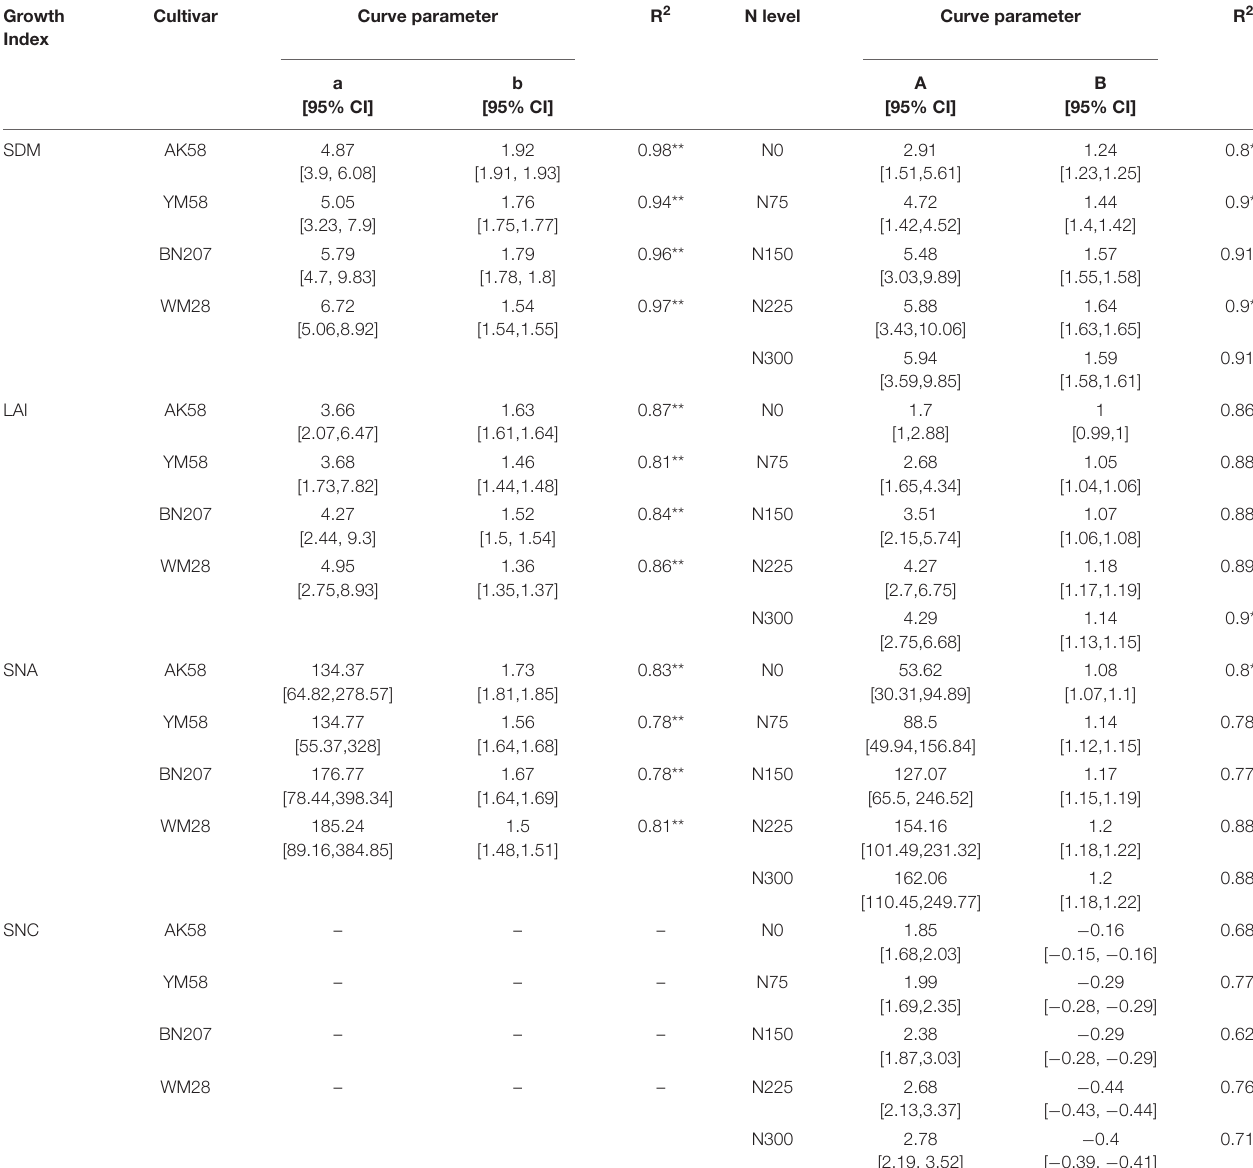
TABLE 4 | The model parameters and 95% confidence interval (CI) of the relationships between canopy cover (CC) and growth indices across different cultivars and nitrogen levels. Growth Cultivar Curve Index